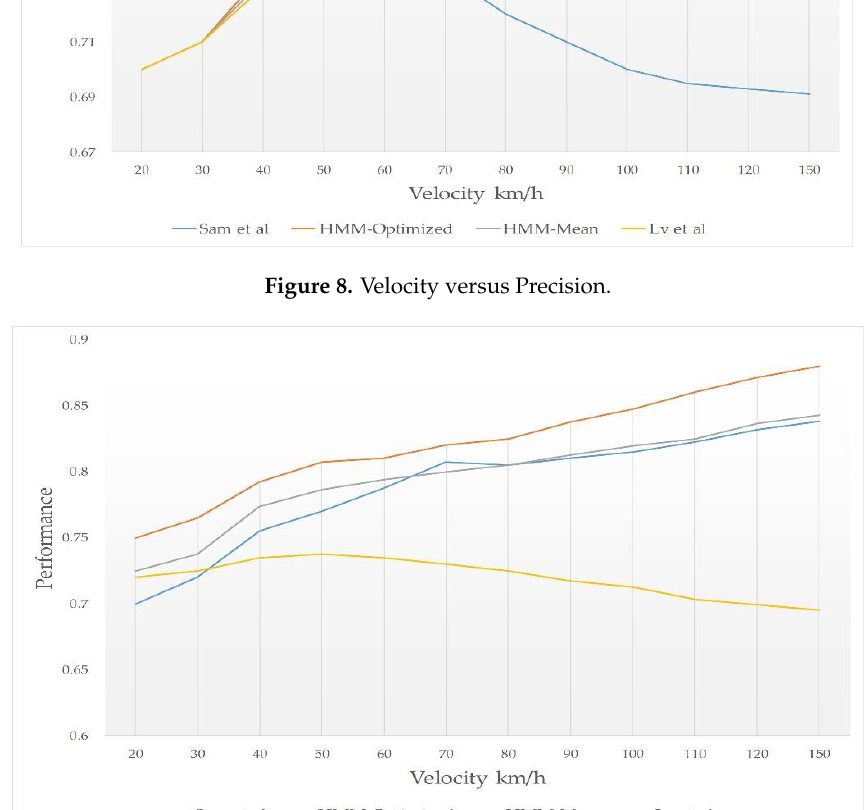
Figure 9. Velocity VS Performance.